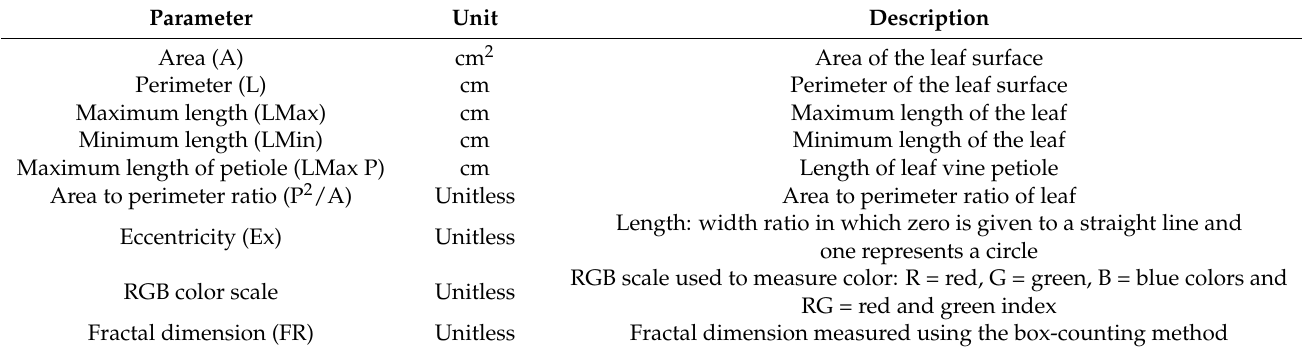
Table 1. Description of the leaf morpho-colorimetric features for variety characterization and discrimination. Parameter Unit Description Area (A) cm 2 Area of the leaf surface Perimeter (L) cm Perimeter of the leaf surface Maximum length (LMax) cm Maximum length of the